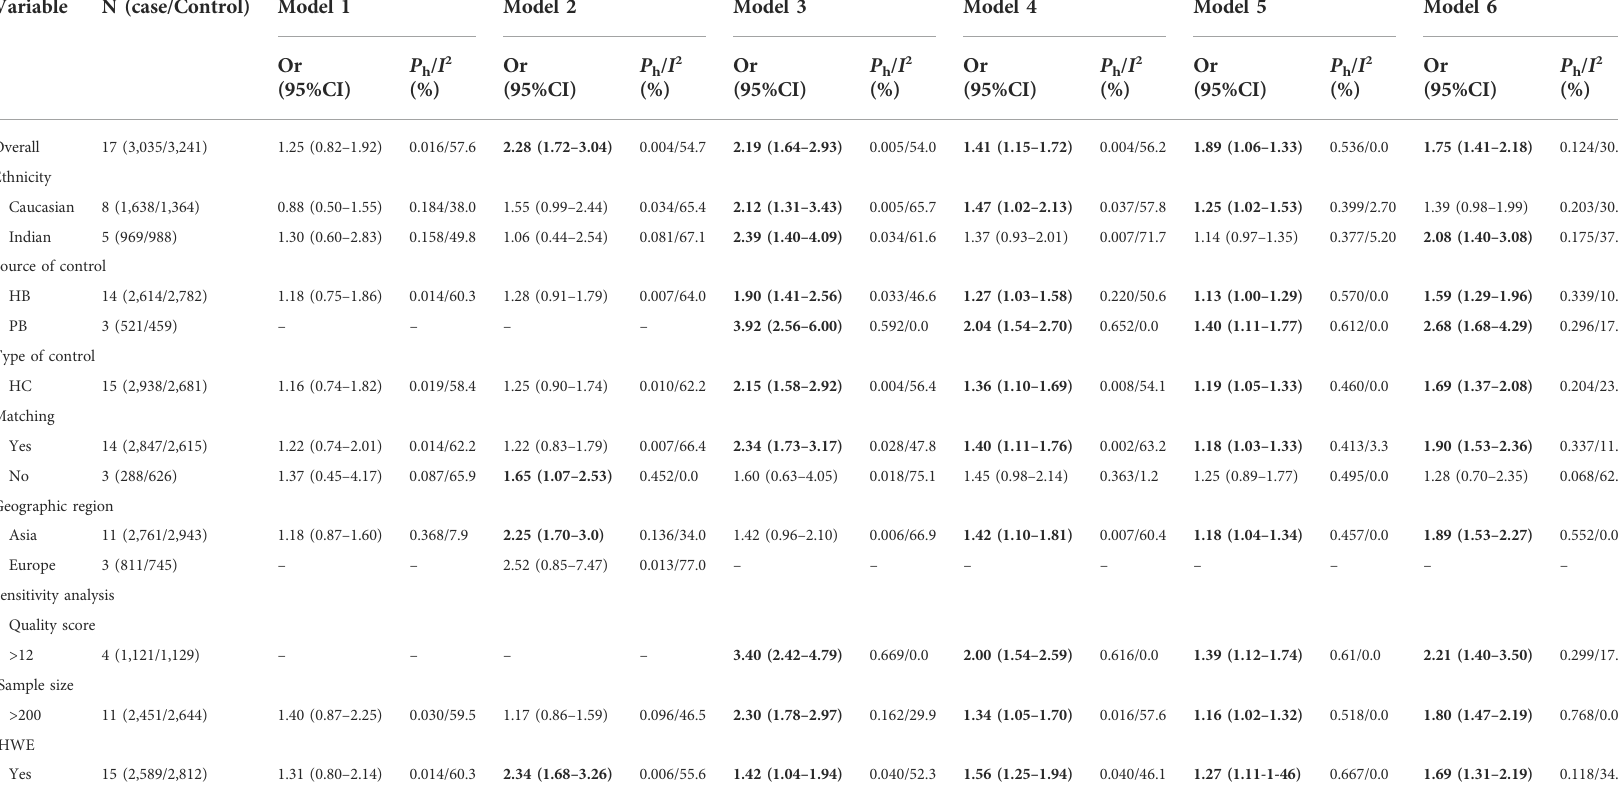
TABLE 4 Meta-analysis of the combined effects of GSTM1 present/null and GSTT1 present/null on T2DM risk.